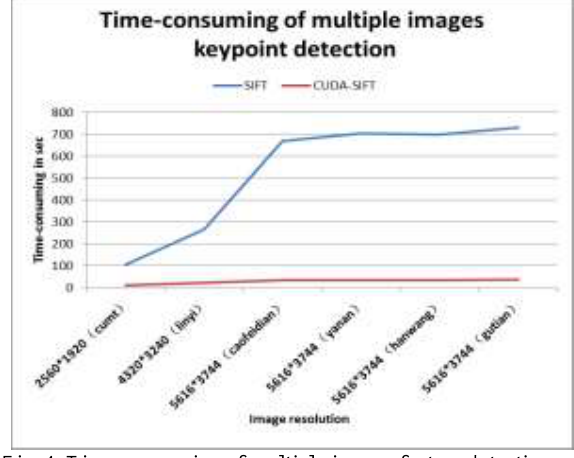
Fig. 4 Time-consuming of multiple images feature detection